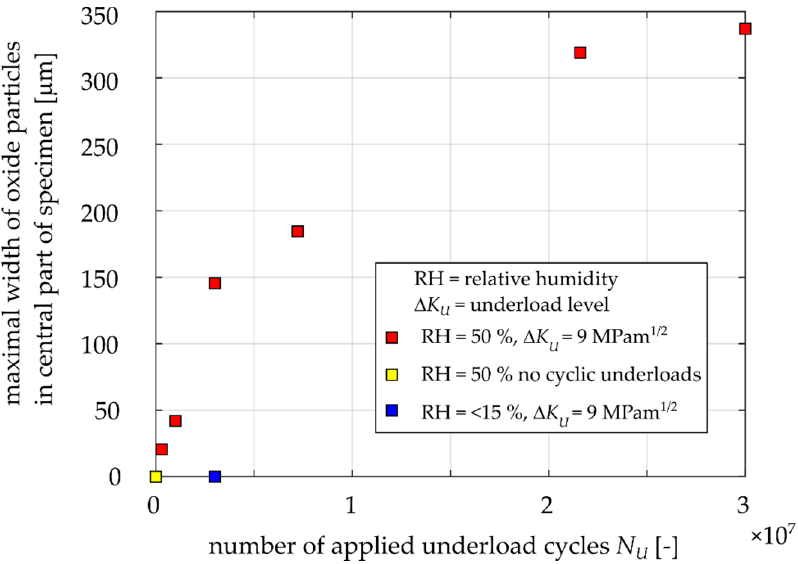
Figure 15. Determined maximal widths of oxide layers for the Specimens 3, 4, 7, 8, 10, 11, 12, 14, 15 and 16 based on EDS maps